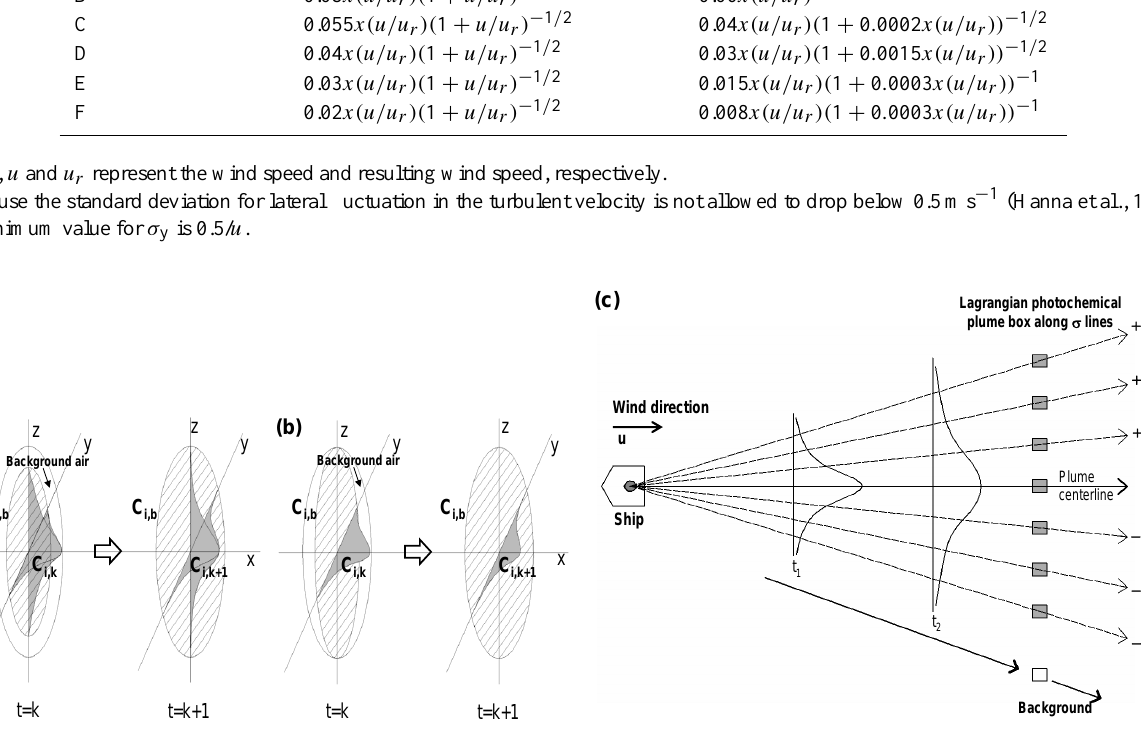
Fig. 1. Schematic diagram of ship-plume dispersion, (a) when σ z < 0.8h and (b) when σ z > 0.8h. (c) The illustration is shown for multiple Lagrangian ship-plume photochemical box runs. The grey boxes represent the air parcels inside the ship plume, whereas the white box represents an air parcel outside the ship